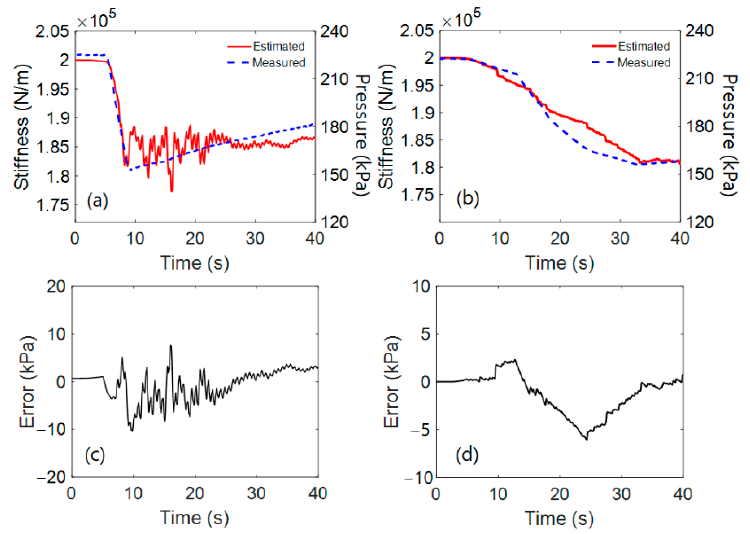
Figure 13. Experimental results of tire stiffness estimation; ( a , c ) tire stiffness estimation response and estimation error for sudden drop and slowly recovered pressure change (224 kPa → 142 kPa → 180 kPa), ( b , d ) response and estimation error for different slew rate limited reference input.